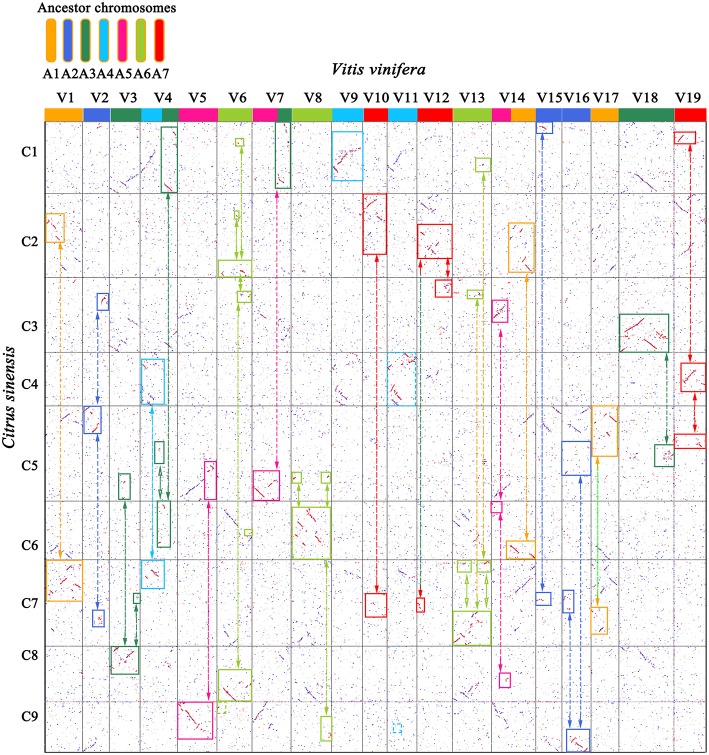
Genome homology between grape (V) and sweet orange (C). Best-matched genes from two genomes are colored in red, secondary matches in blue, and others in gray. The 19 grape chromosomes are shown in 7 colors, corresponding to their 7 ancestral proto-chromosomes before the ECH. Orthologous blocks were identified by solid-line rectangles. Bi-directional arrows link complementary correspondence showing inferred chromosome breakages during evolution of sweet orange.